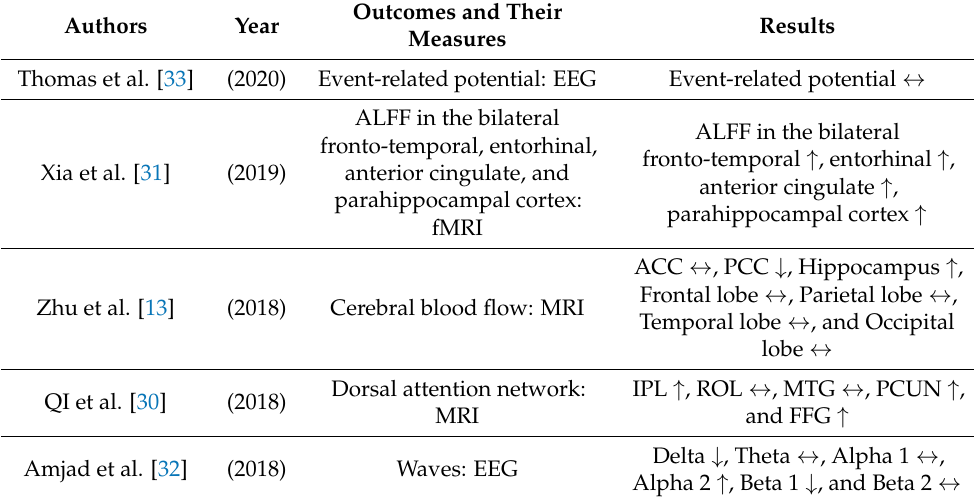
Table 4. The overall results of the brain activity in reviewed